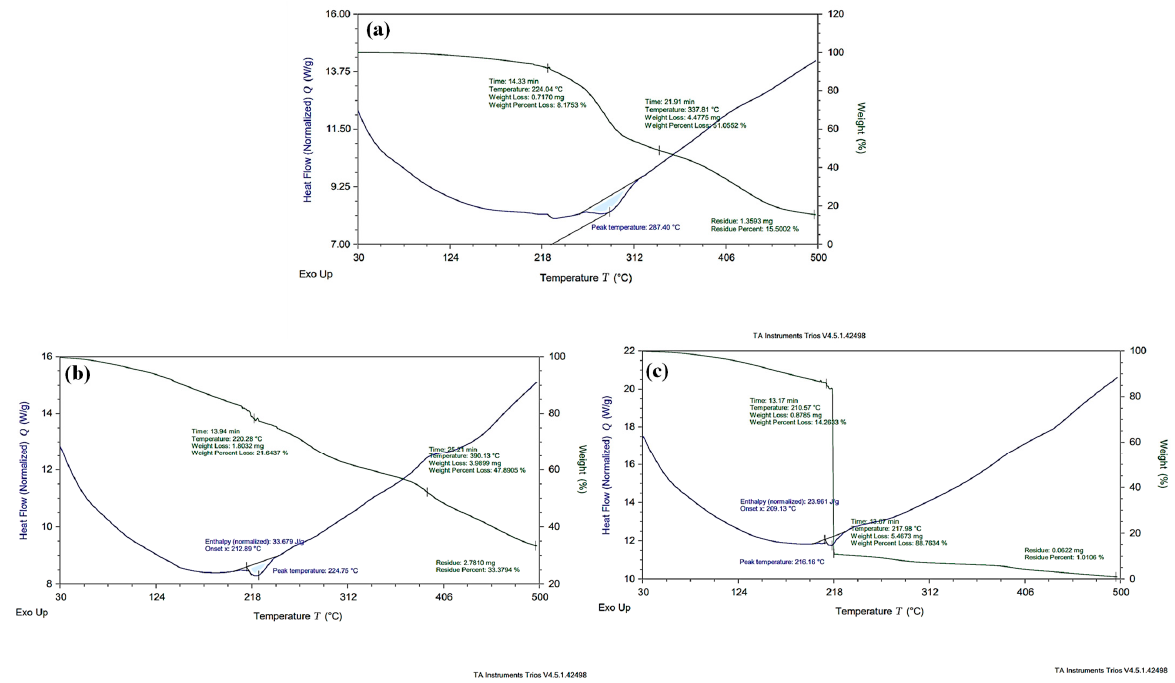
Figure 8. Comparative DLC versus TGA curves of ( a ) unloaded BA hydrogel ( b ) Ins-BA hydrogel ( c ) Ins-Mmt-BA hydrogel NC. 3.11. In Vitro Release Studies Insulin release against time was determined from all hydrogel (Ins-BA1 to Ins-BA6) and hydrogel NC (Ins-Mmt-BA1 to Ins-Mmt-BA6) formulations. In vitro release profiles of Ins-BA hydrogels with different MBA (Ins-BA1 to Ins-BA3) and monomer AA (Ins-BA4 to Ins-BA6) concentrations are given in Figure 9a. It can be observed that, in Ins-BA1 to Ins-BA6, the percentage release of insulin was less than 2.3% for the first 2 h at pH 1.2. After that, up to 12 h, the percentage release was dramatically increased at pH 7.4 in all hydrogel formulations. In Ins-BA1 to Ins-BA3 hydrogels, the drug release was decreased from 96.08 to 86.17% with an increase in MBA contents ( p -value > 0.05). This effect was due to an increase in crosslink density with the increase in MBA contents and resultant decreased swelling of hydrogel networks, leading towards a decrease in drug percentage release too. In the case of Ins-BA4 to Ins-BA6 hydrogels, the maximum release was in- creased from 91.14% to 99.38% with an increase in AA contents ( p -value > 0.05). This in- crease in % release was due to more swelling of the hydrogel network because of greater repulsive forces caused by a larger number of ionized carboxylic acid (-COOH) groups of AA at pH 7.4 [25,29]. A p -value > 0.05 indicated that no significant difference existed be- tween release patterns of insulin from hydrogel formulations. Meanwhile, in the case of Ins-Mmt-BA1 to Ins-Mmt-BA6 hydrogel NCs (Figure 9b), the same trend was observed in drug release. For example, by increasing MBA content in Ins-Mmt-BA1 to Ins-Mmt-BA3, a decrease in % release from 93.52% to 82.01% was ob- served ( p -value > 0.05). Similarly, by increasing AA contents in Ins-Mmt-BA4 to Ins-Mmt- BA6, an increase in swelling and % release was observed from 88.14% to 96.17% ( p -value > 0.05). Thus, it is also evident that no significant difference between release patterns of insulin from hydrogel NC formulations was present. However, an overall increase in re- lease time (up to 24 h) for all hydrogel NC formulations can be observed as compared to hydrogels (up to 12 h). This difference in insulin release time is due to incorporation of Ins-Mmt in all hydrogel NC formulations, causing an increase in crosslink density. This